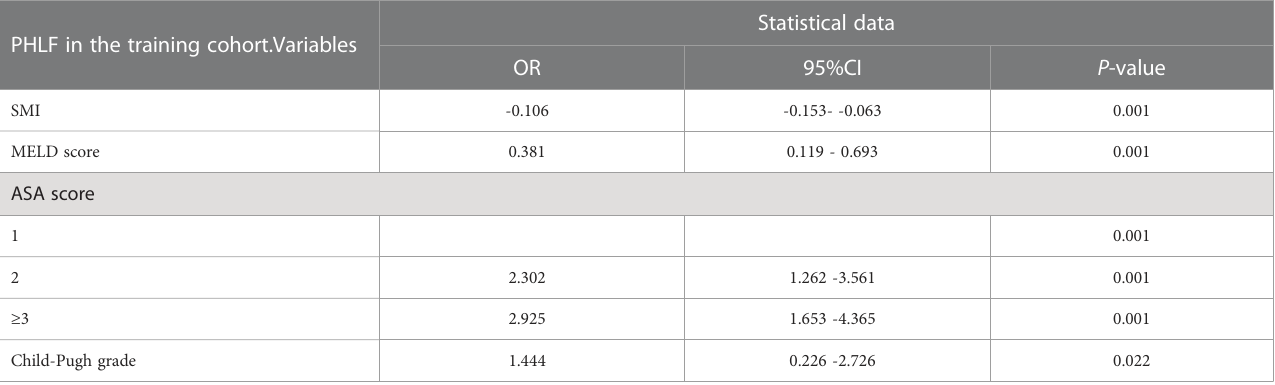
TABLE 2 Multivariable logistic regression analyses of grade B/C.